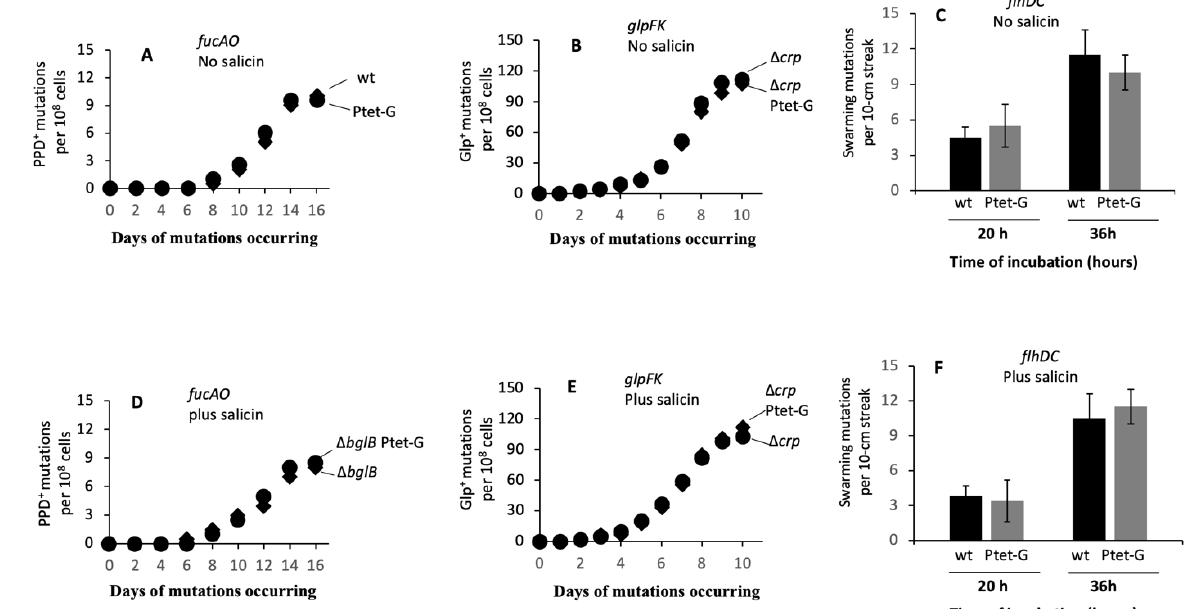
Figure 4. Increased expression of bglG affects only IS insertions into the bgl operon but not the fucAO , glpFK and flhDC operons. ( A ) Effect of bglG expression on PPD + mutations. A total of 10 8 cells were applied onto M9 + PPD plates, and PPD + colonies were counted over time. ( B ) Effect of bglG expres- sion on Glp + mutations. A total of 2 × 10 7 cells of a crp deletion strain with or without P tet driving bglG were applied onto M9 + glycerol plates, and Glp + colonies were counted over time. ( C ) Effect of bglG expression on swarming mutations. A total of 2 × 2 μL of cell suspensions with an OD 600 of 1 were streaked over the surface of LB + 0.3% agar. Swarming mutants (as super swarming subpop- ulations) were counted per streak after 20 and 36 h of incubation at 30 °C. ( D ) Effect of bglG expres- sion on PPD + mutations in the presence of salicin. A total of 10 8 cells of strains Δ bglB and Δ bglB _Ptet- G were individually applied to M9 + PPD + salicin (0.5%) plates. ( E ) Effect of bglG expression on Glp + mutations in the presence of salicin. A total of 2 × 10 7 cells of strains Δ crp and Δ crp _Ptet-G were individually applied to M9 + glycerol + salicin (0.5%) plates. ( F ) Effect of bglG expression on swarm- ing mutations in the presence of salicin. A total of 2 × 2 μL of cell suspensions with an OD 600 of 1 were streaked over the surface of LB+ salicin + 0.3% agar.